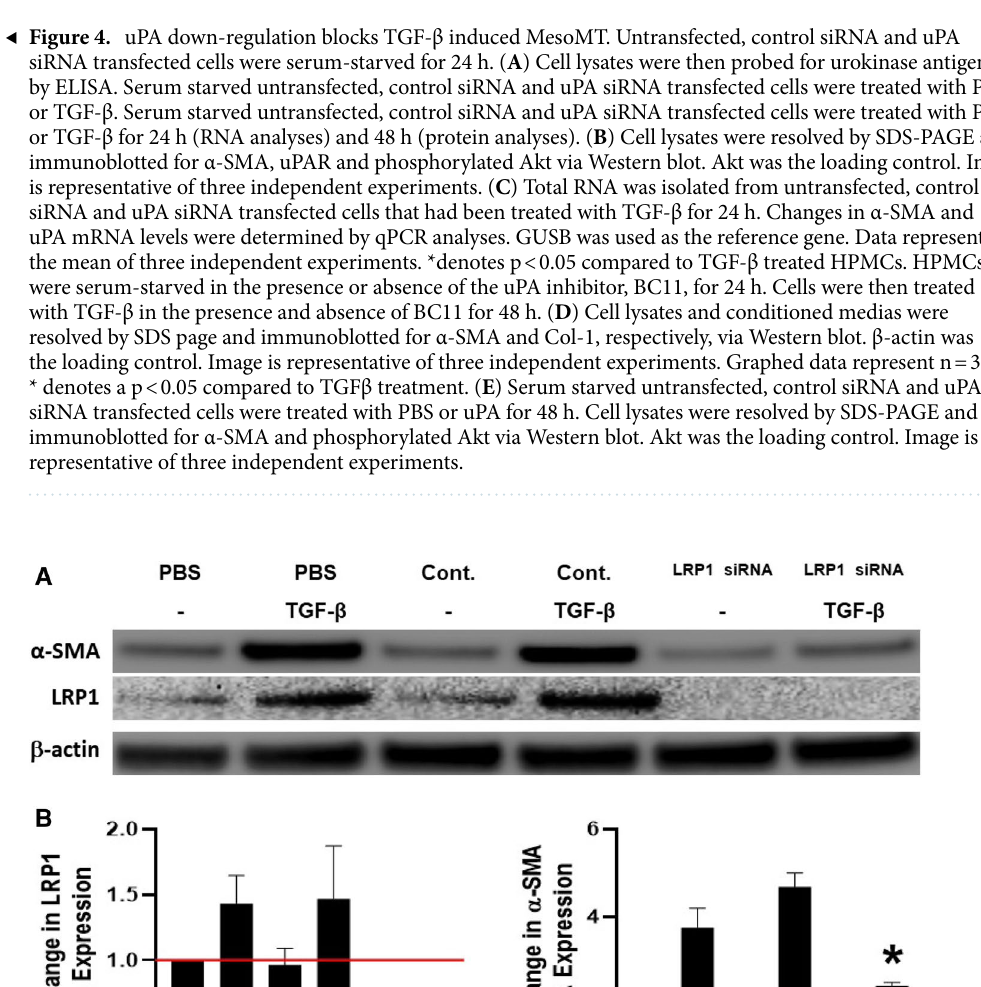
Figure 5. LRP1 down-regulation blocks TGF-β induced MesoMT. Untransfected, control siRNA and LRP1 siRNA transfected cells were serum-starved for 24 h. Serum-starved untransfected, control siRNA and LRP1 siRNA transfected cells were treated with PBS or TGF-β for 24 h (RNA analyses) and 48 h (protein analyses). ( A ) Cell lysates were resolved by SDS-PAGE and immunoblotted for α-SMA Western blot. Akt was the loading control. Image is representative of three independent experiments. ( B ) Total RNA was isolated from untransfected, control siRNA and LRP1 siRNA transfected cells treated with TGF-β for 24 h. Changes in α-SMA and LRP1 mRNA levels were determined by qPCR analyses. GUSB was used as the reference gene. Data represents the mean of three independent experiments. *denotes p < 0.05 compared to siRNA